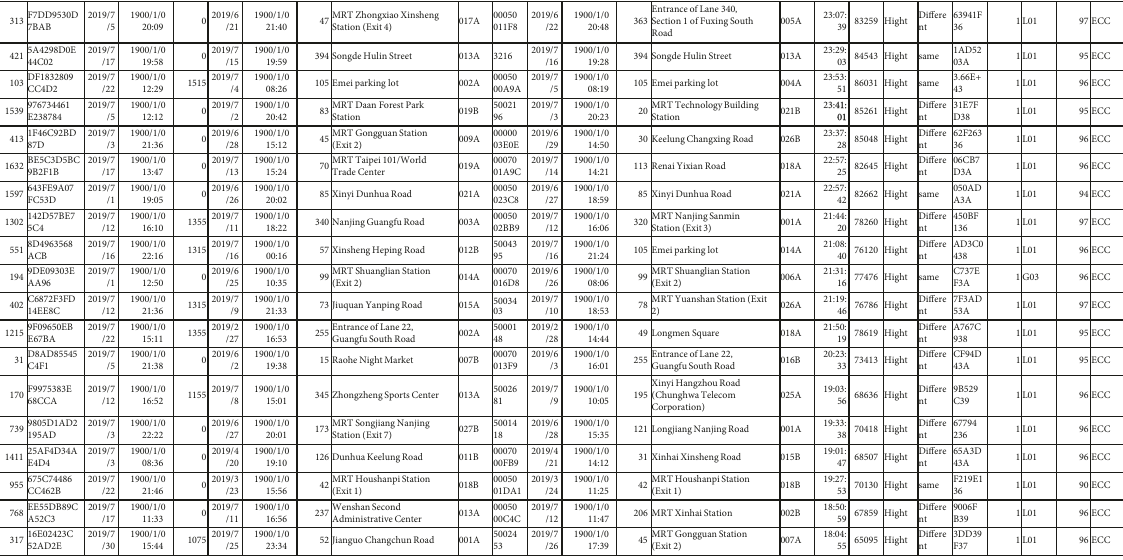
Figure 4: An example of raw data for YouBike riders.